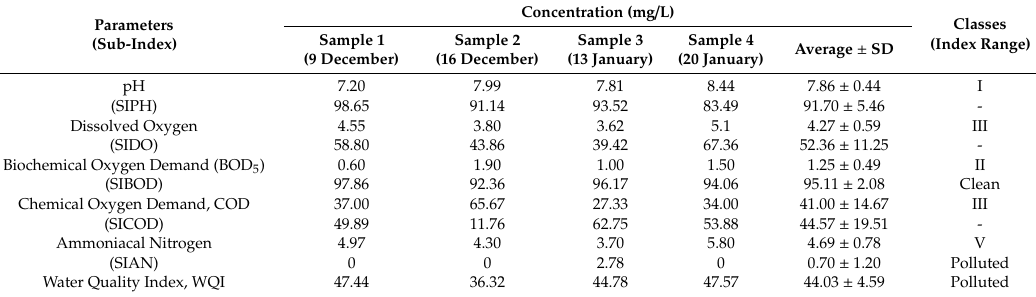
Table 10. Laboratory result (sub-index values) of river water samples